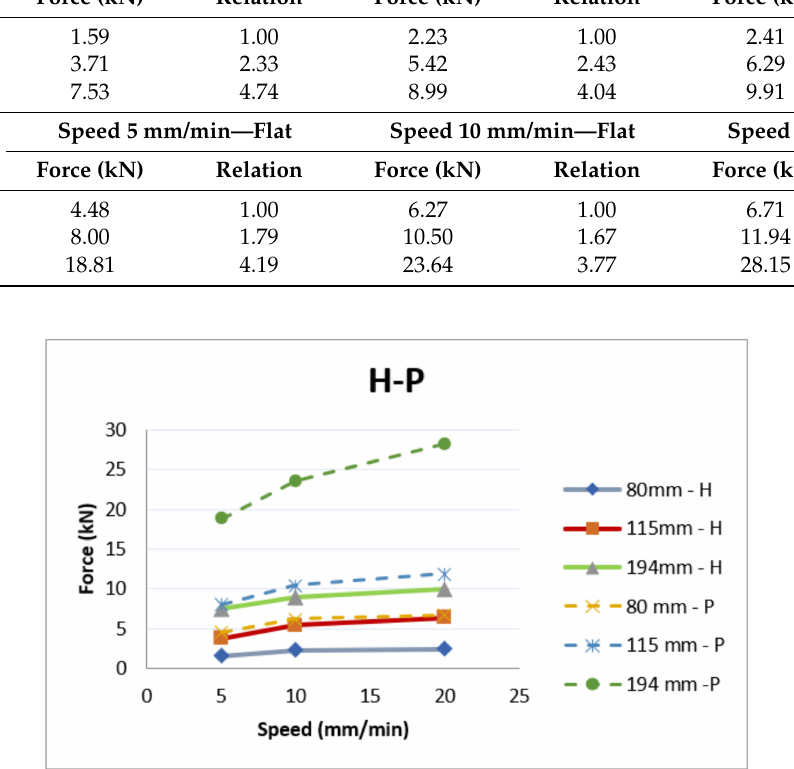
Figure 20. Maximum value of force at each position, speed, and